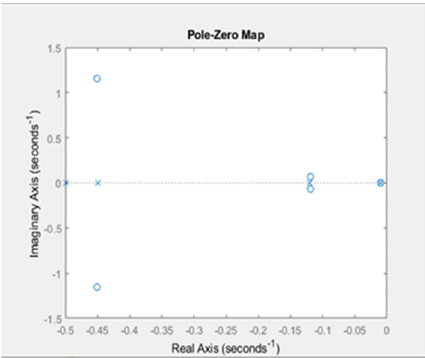
Figure 32. Pole-zero diagram of n = 6 state variables.